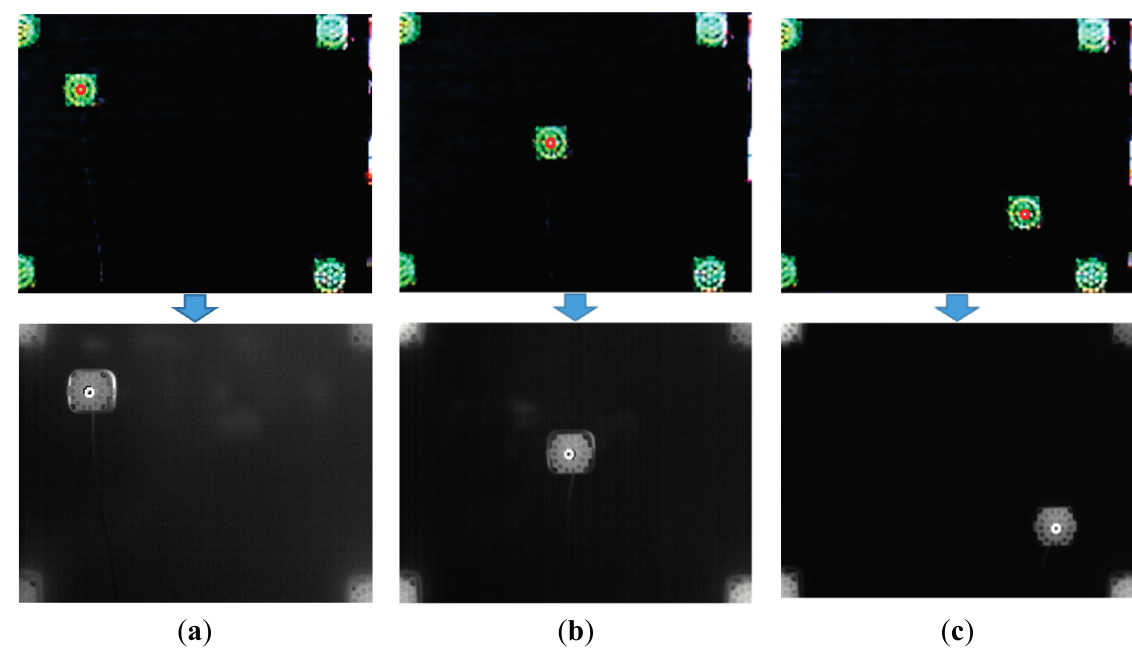
Figure 11. Experiment for measuring the accuracy of the geometric transform. The top and bottom figures of ( a – c ) are images from the visible-light and thermal cameras, respectively.